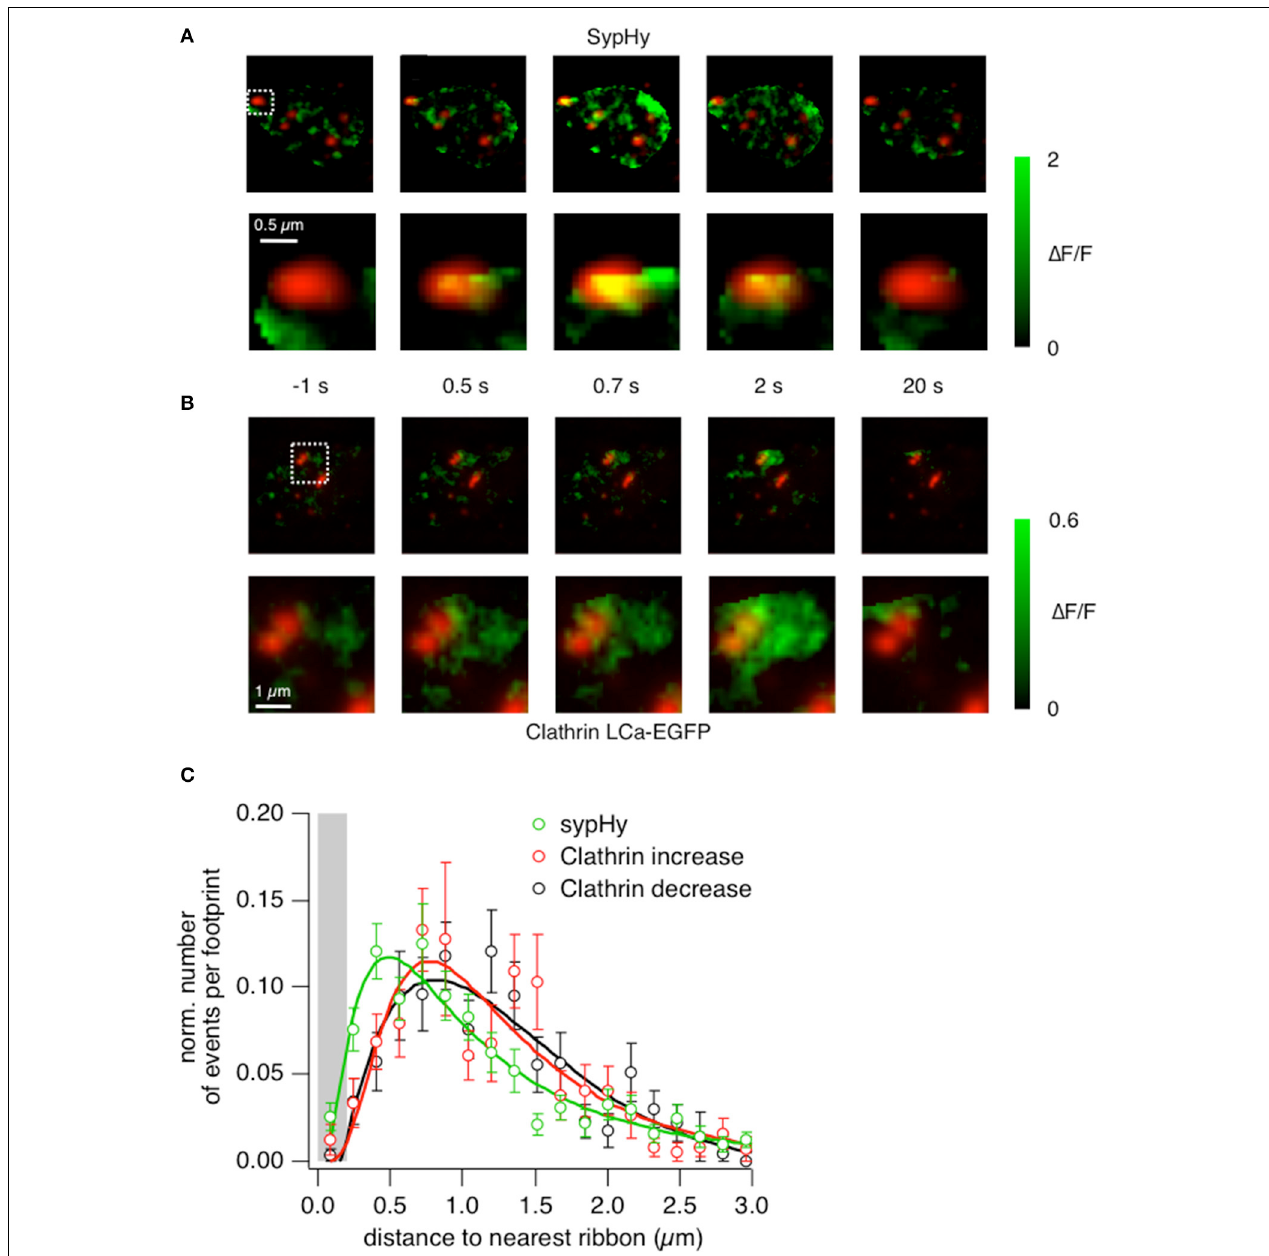
FIGURE 6 | Clathrin accumulates at the periphery of the active zone. (A) TIRF imaging of the synaptic terminal of a bipolar cell expressing sypHy and ribeye-mCherry. Images show the relative change in fluorescence at times indicated relative to the start of a depolarizing stimulus lasting 0.5s. The lower sequence is zoomed into the area marked by the square. Note that the signal generated in the first 0.5s is closely localized to the active zone. (B) TIRF imaging of clathrin LCa-EGFP and ribeye-mCherry. The lower sequence